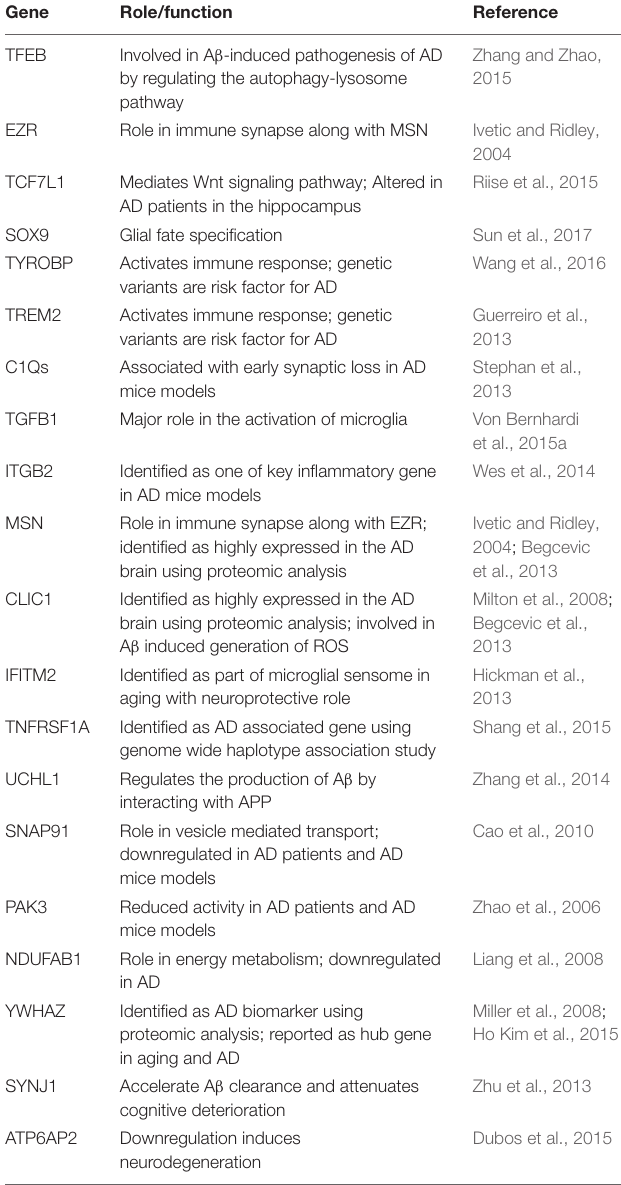
TABLE 3 | Module hub genes in aging and